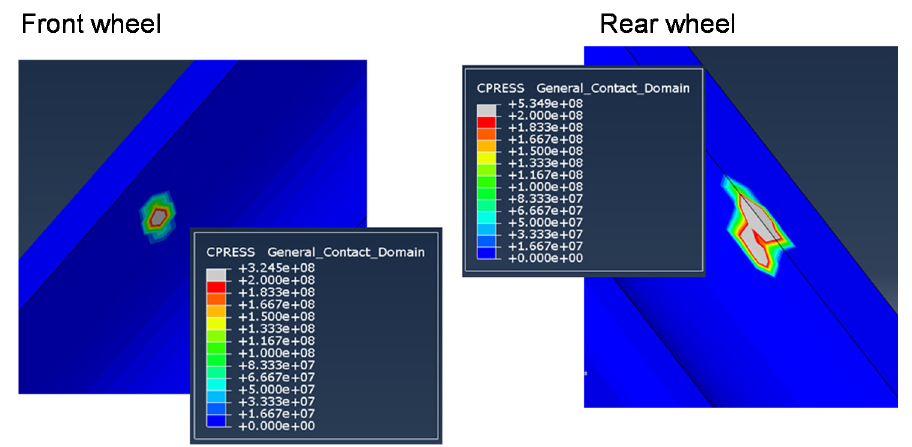
Figure 17. Maximum contact pressure in the rail.